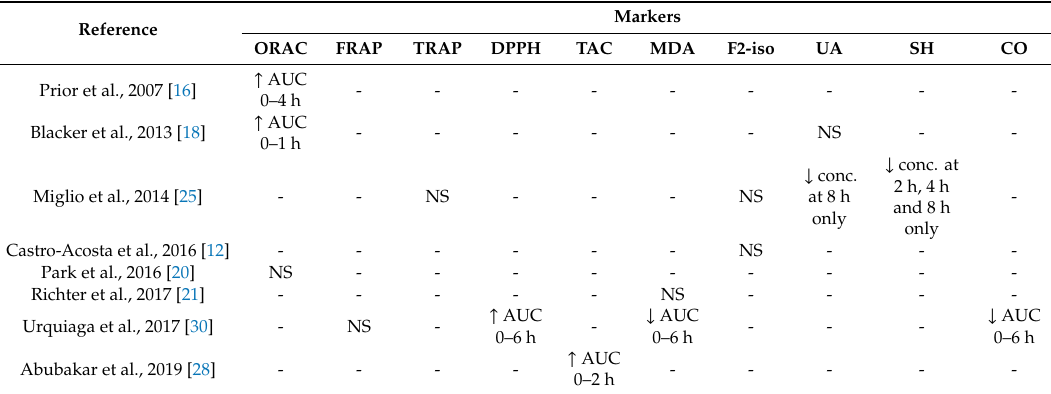
Table 7. E ff ects of anthocyanin intake in composite meals on markers for oxidative stress and antioxidant